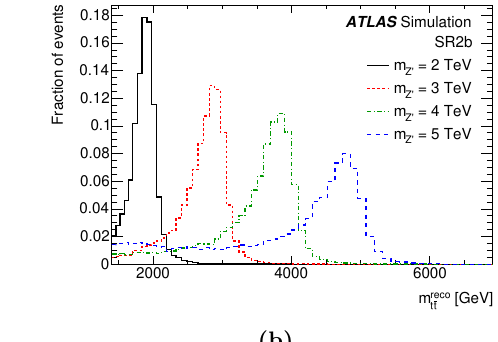
! t (cid:22) t signal events for Z 0 TC2